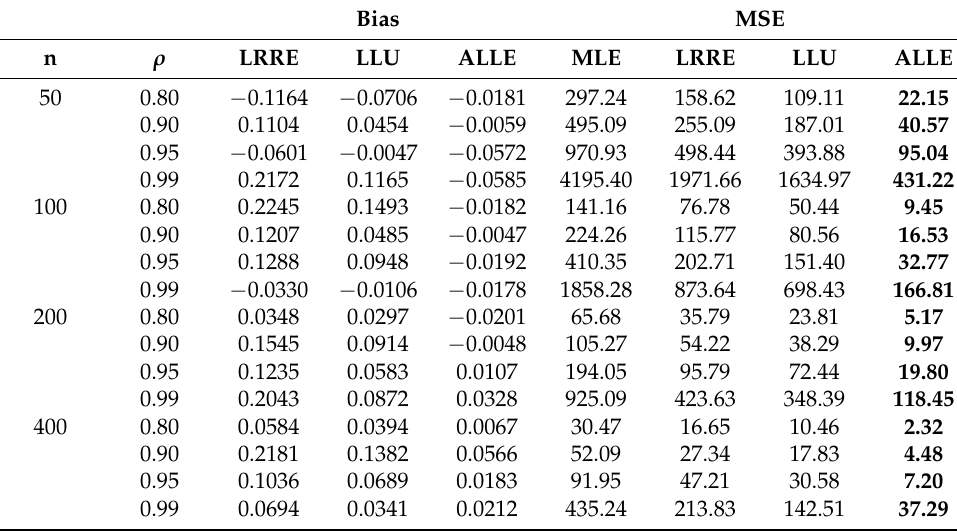
Table 1. Bias and MSE values of the estimators for p =